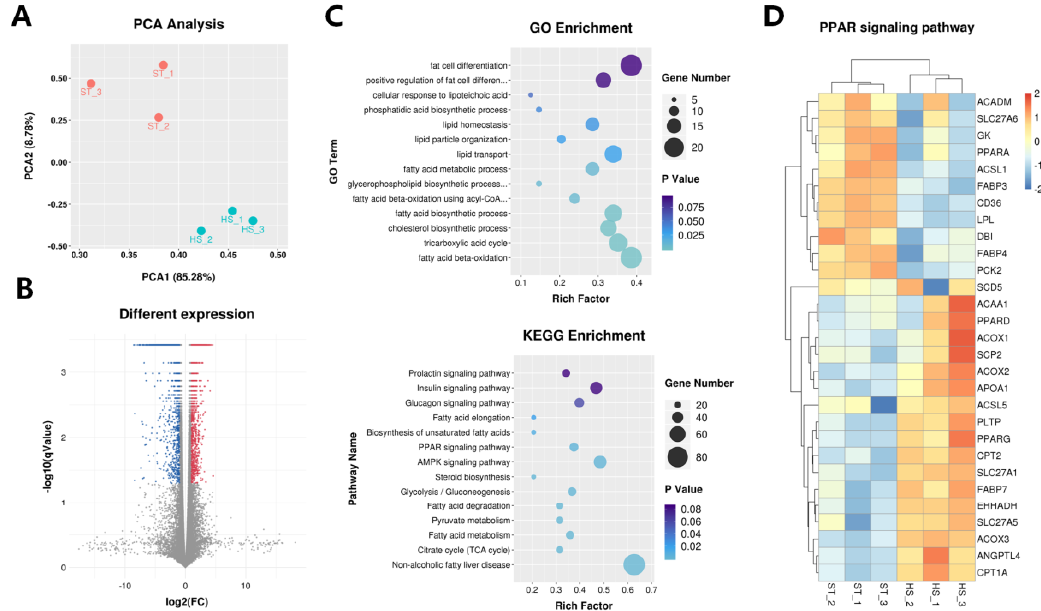
Figure 2. Transcriptome analysis of the mammary gland of dairy cows under heat stress. ( A ) principal component analysis of the whole transcripts in the mammary gland of dairy cows under heat stress; ( B ) volcano plot, showing significantly differentially expressed genes; ( C ) GO and KEGG analysis of differentially expressed genes; ( D ) heatmap, displaying the lactation-related gene identified in PPAR signaling pathway. ST, the appropriate temperature group; HS, heat stress group.